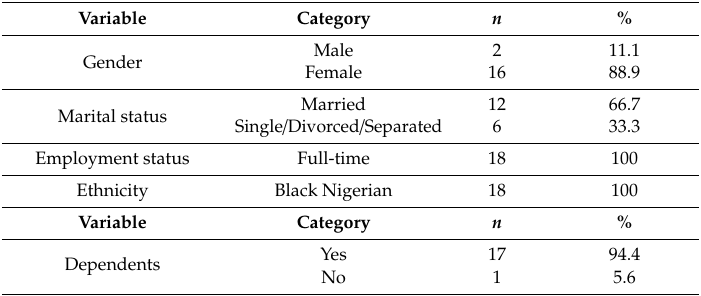
Table 1. Demographic characteristics of